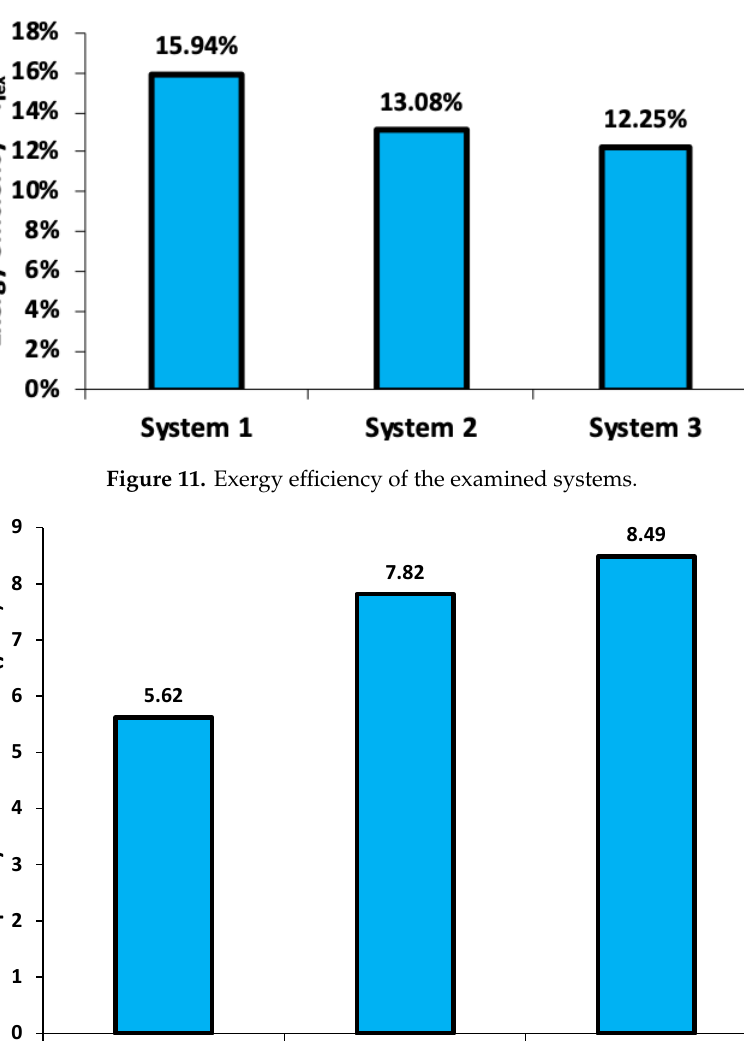
Figure 12. Simple payback period of the examined systems.